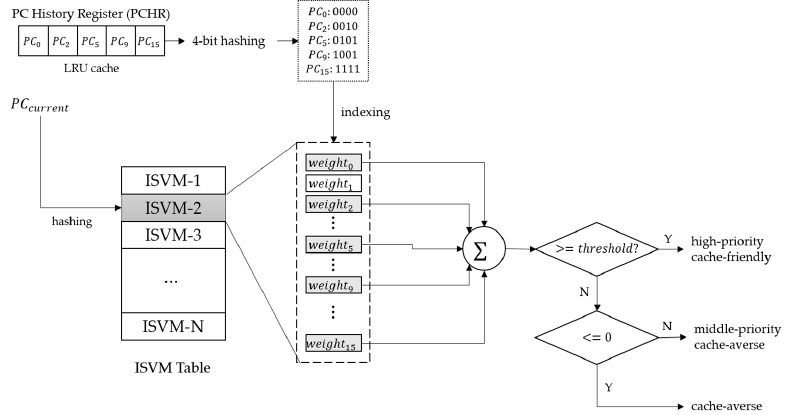
Figure 14. The Glider Predictor [15]: Glider selects the ISVM as a currently accessed PC and deter- mines the cache priority based on the sum of the weights associated with the previously accessed